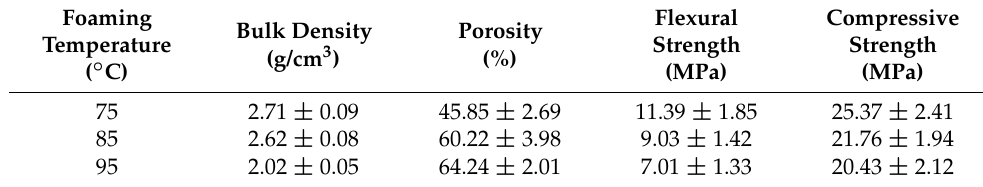
Table 2. Effects of foaming temperature on the properties of SiC porous ceramics with 7.5 wt.% H 2 O 2